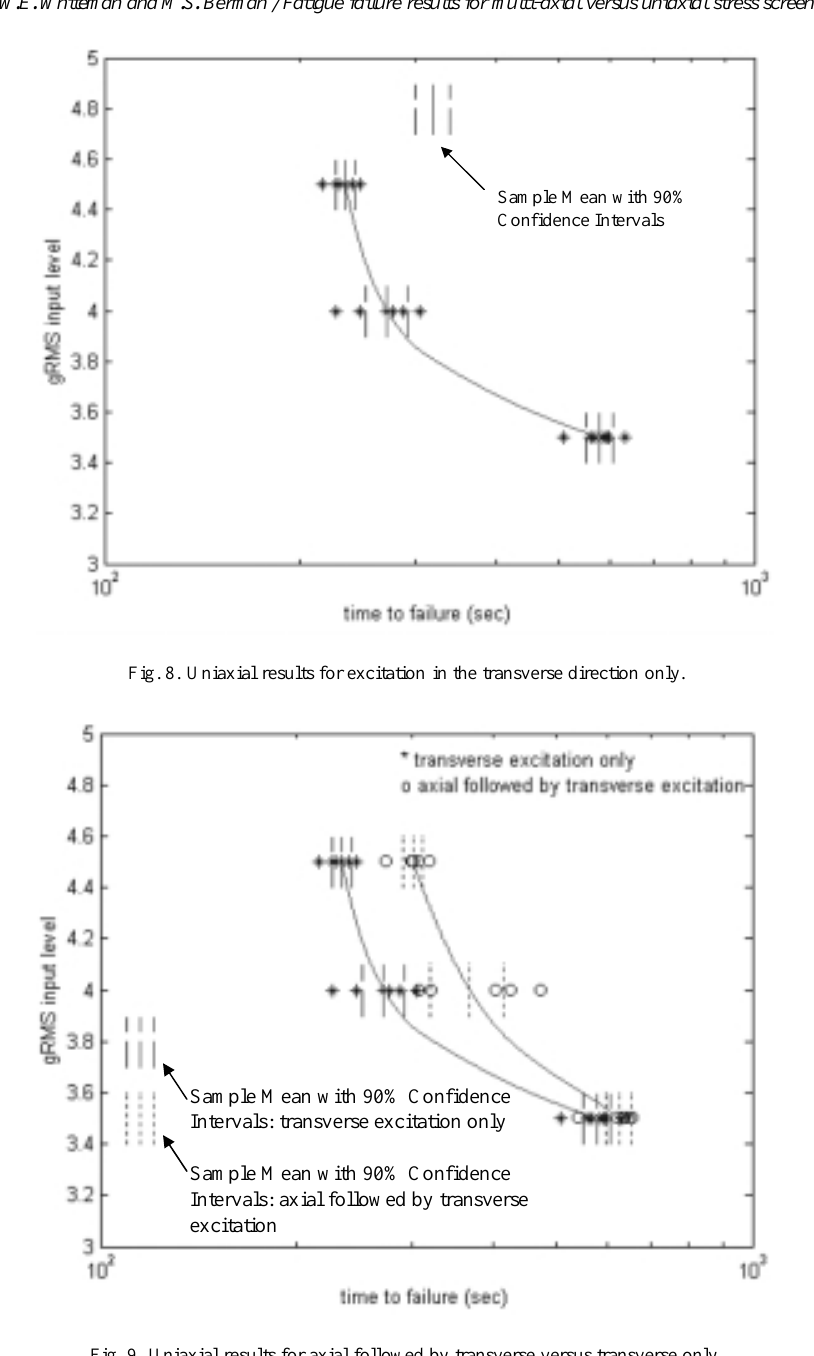
Fig. 9. Uniaxial results for axial followed by transverse versus transverse